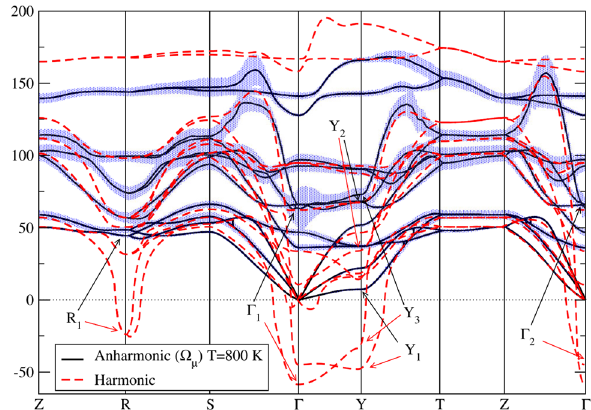
Fig. 9 Harmonic and anharmonic phonons in the Lorentzian approxi- mation for SnSe. The length of the blue bars corresponds to the linewidth (full length of the line is the full width at half maximum). The calculations were performed with LDA on the experimental structure. Adapted with permission from Ref. [159]. Copyright 2019 American Society of